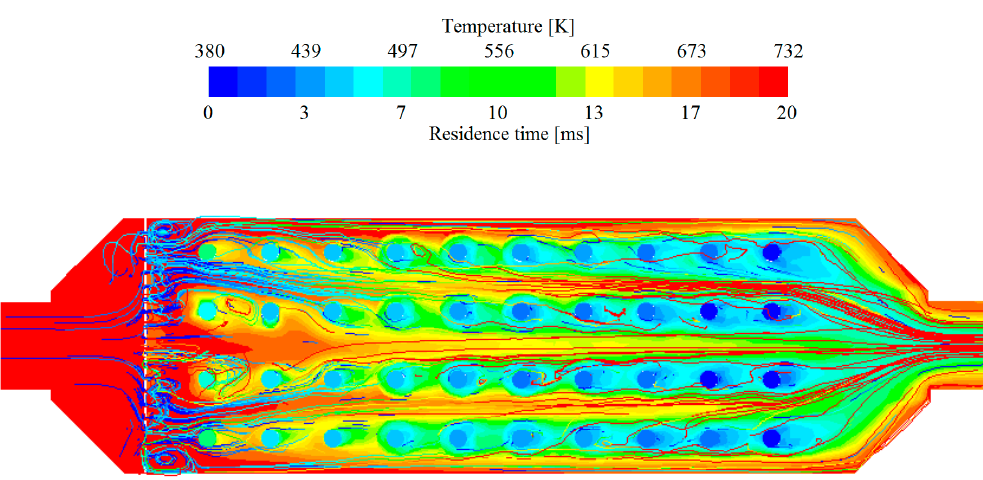
Figure 5. Streamlines and temperature distribution in a horizontal plane at moderate engine load.